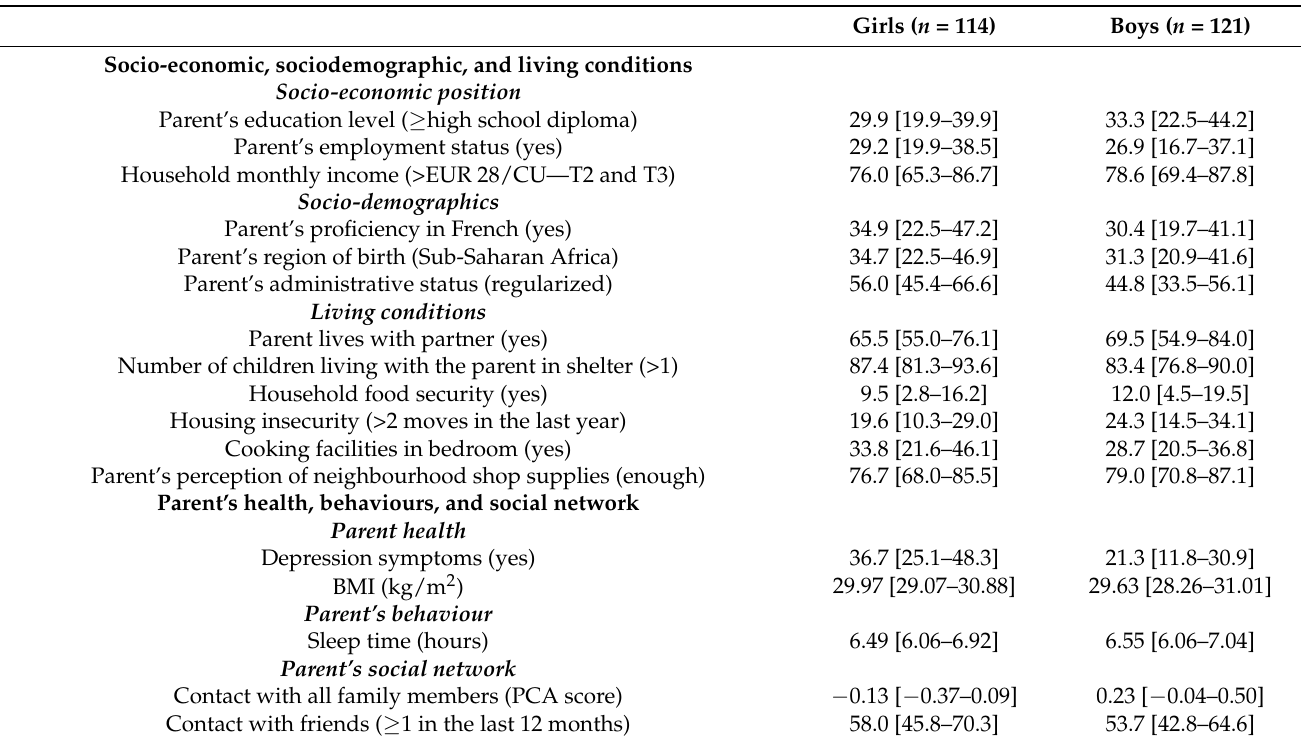
Table 1. Family socio-ecological factors and health characteristics (weighted mean or percentage [95% CI]). 1 The ENFAMS